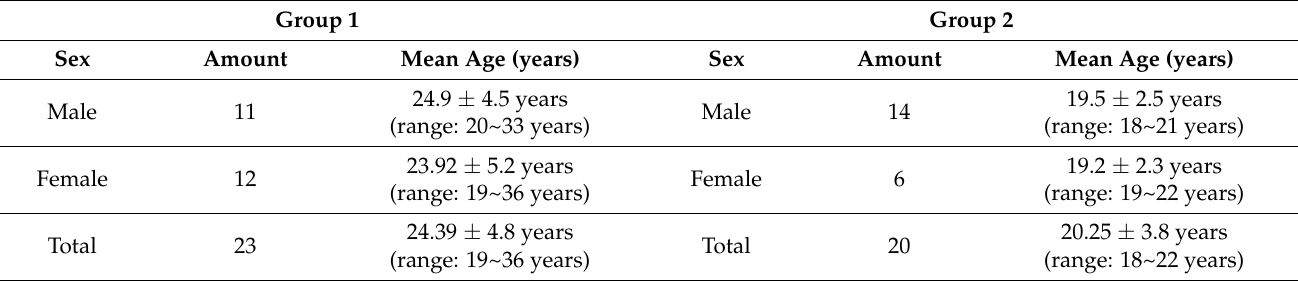
Table 1. Distribution of samples (Group 1: skeletal Class III patients; Group 2: skeletal Class III cleft patients with retrusive mid-face) by sex and